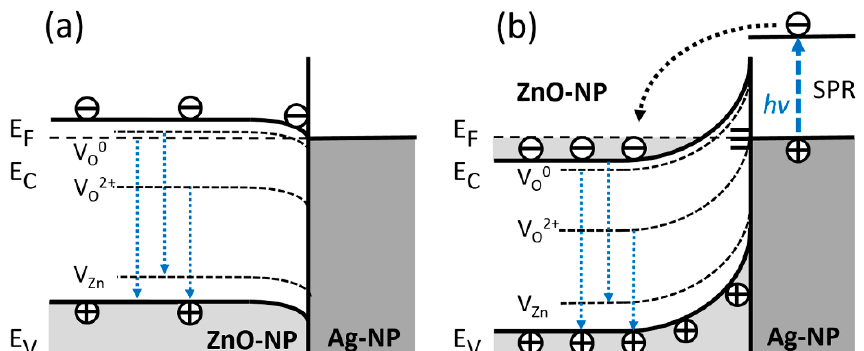
Figure 7. Sketch of optical phenomena in the nanohybrid structures at the interface of ZnO–Ag NP: ( a ) “Ideal” Ohmic contact model, where the interfacial band-bending is downwards because of the larger working function of ZnO than of Ag (~4.7–5.2 eV vs. 4.26 eV, respectively). ( b ) “Realistic” Schottky barrier model with upward band-bending at ZnO NP surfaces induced by interface states of adsorbents, such as hydroxyl groups and oxygen radicals.